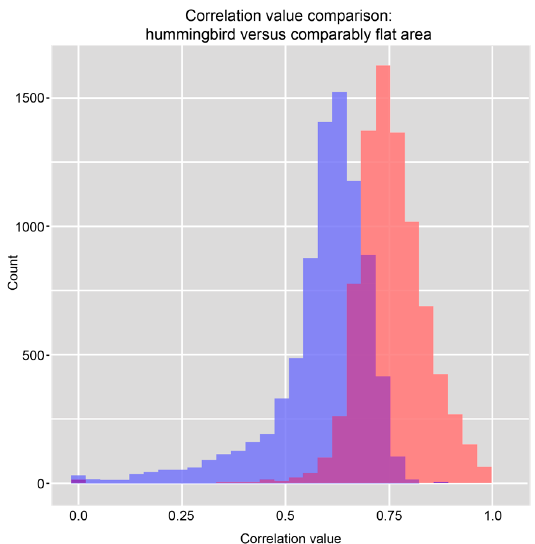
Figure 9. Histograms of the correlation values of the pixels falling within the Hummingbird and its immediate area ( blue ) and a random sample of comparable cells from nearby, flat areas without radar shadow ( red